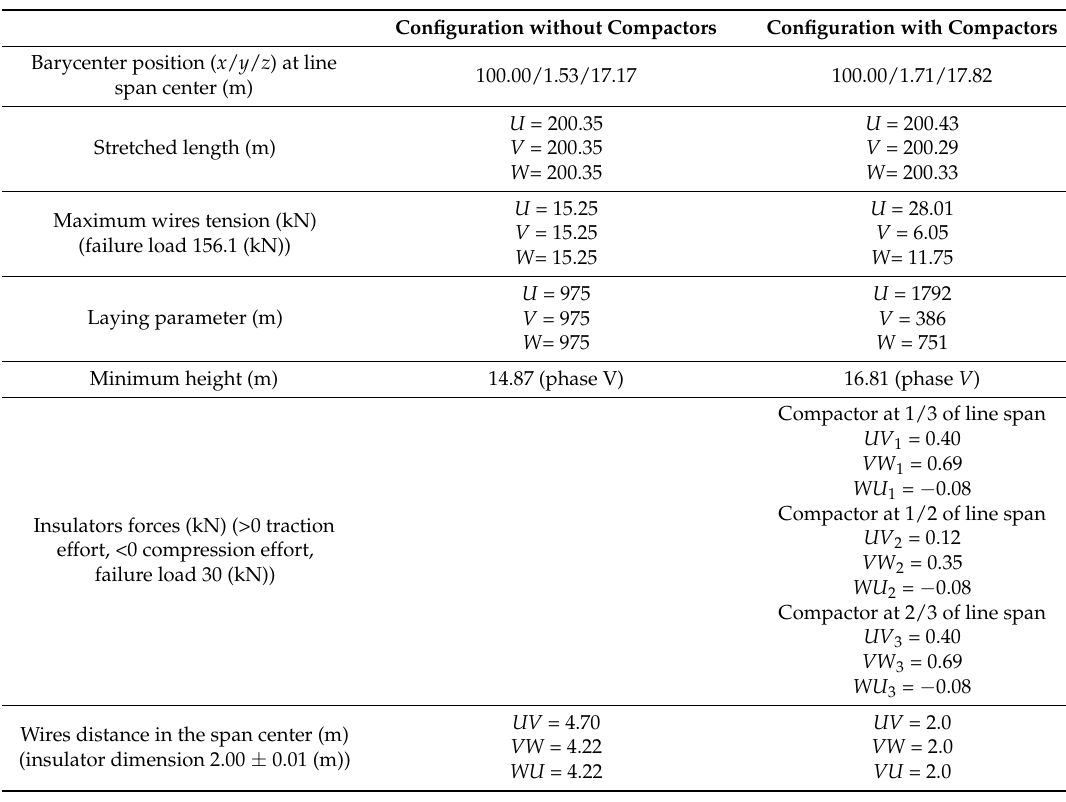
Table 3. Mechanical results without and with three compactors along the line span (EDS